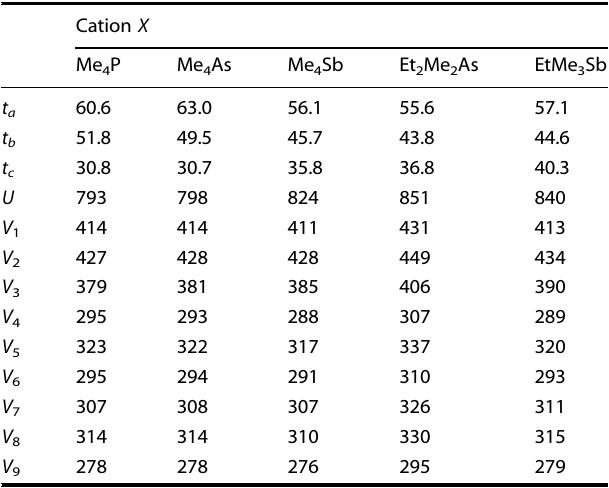
Table 1. Derived parameters of the ab initio effective Hamiltonian for X [Pd(dmit) 2 ] 2